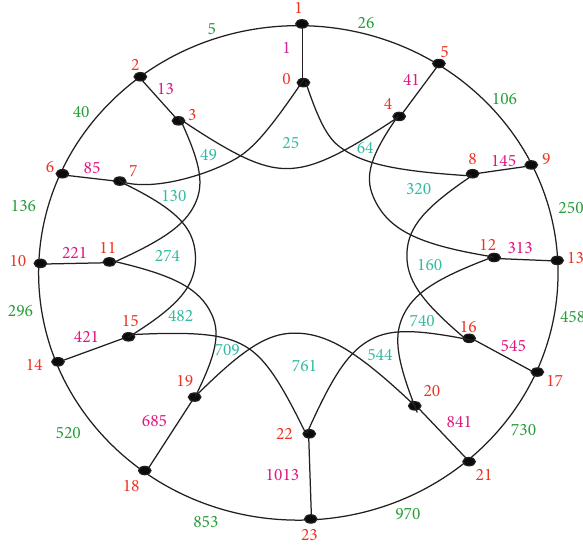
Figure 1: Square sum labeling of Petersen graph P [ 12 , 2 ]